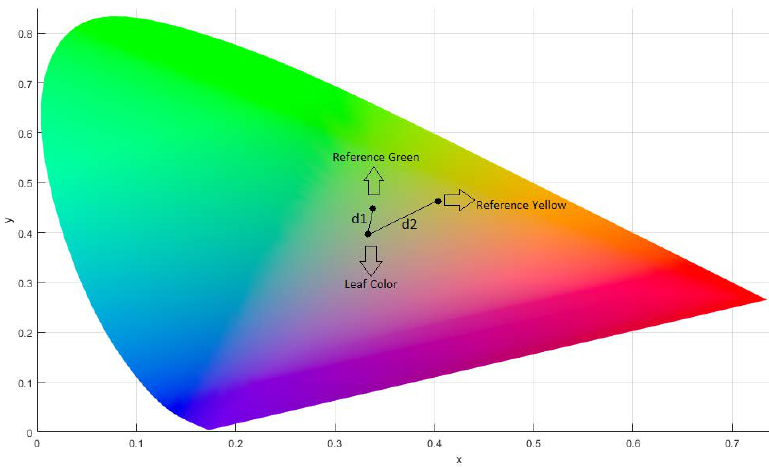
Figure 5. CIEXYZ Chromaticity